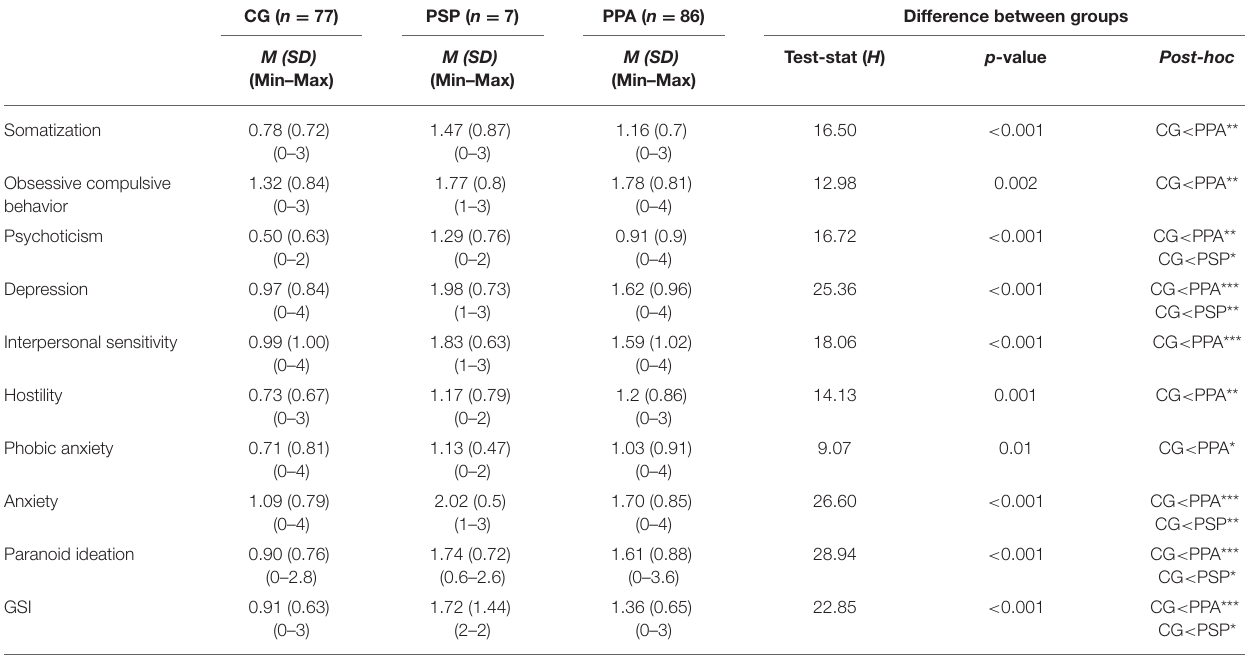
TABLE 5 | Self-reported psychiatric distress level in a sample of female adolescents according to psychosocial variable groups.